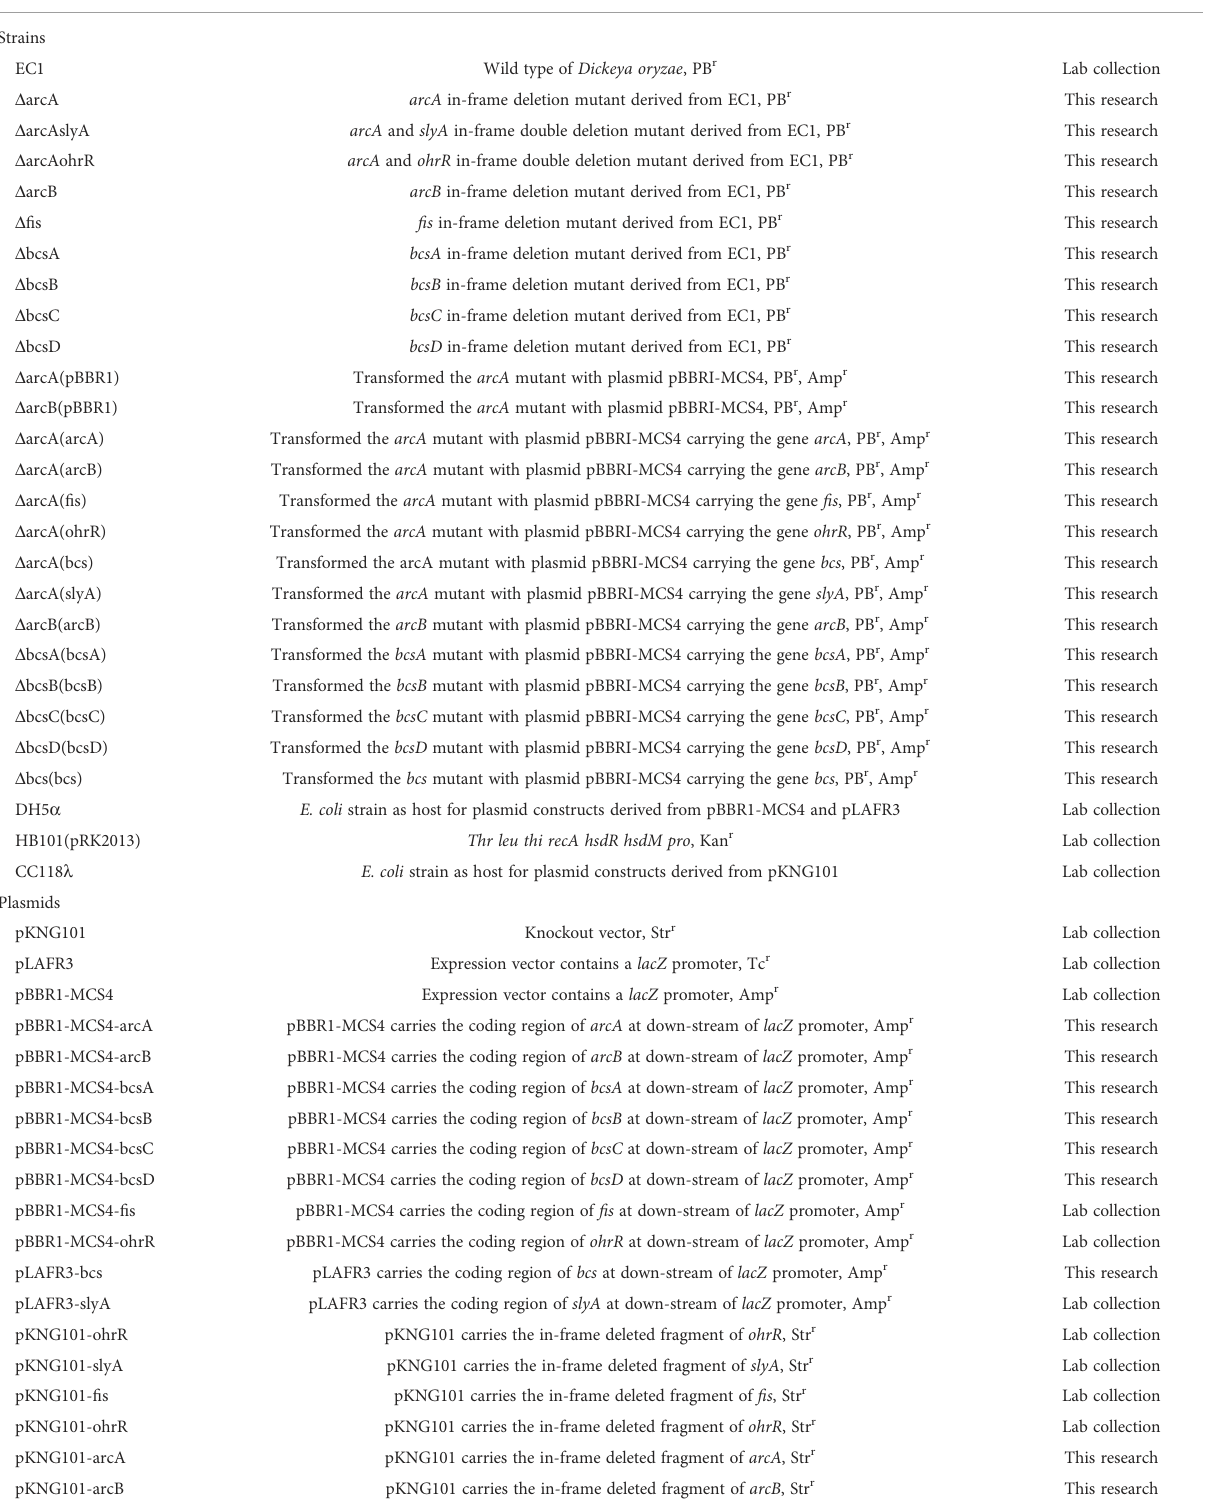
TABLE 1 Strains and plasmids used in this study. Strains or